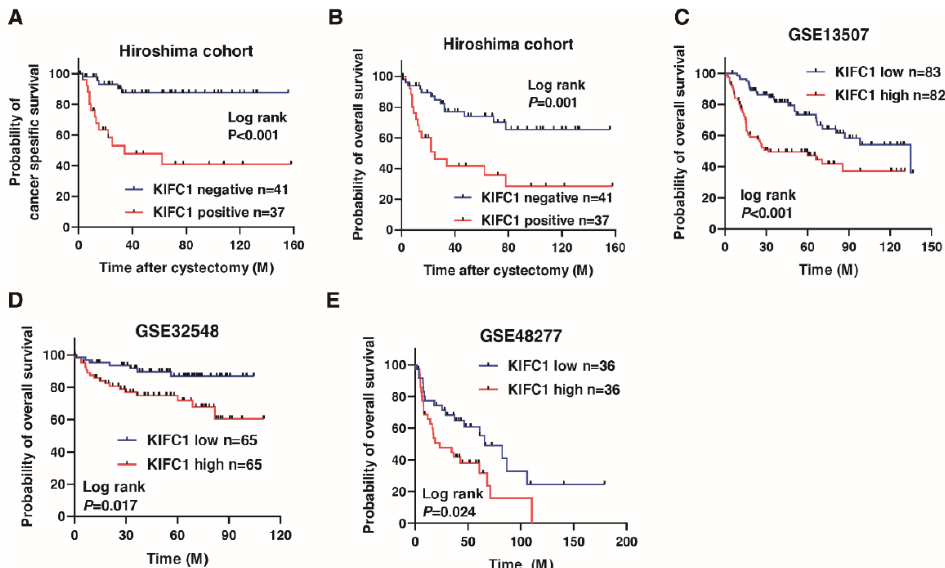
Figure 2. Prognostic value of KIFC1 after cystectomy in bladder cancer (BC). ( A – E ) Kaplan-Meier plots of survival of BC patients after cystectomy according to KIFC1 expression in the Hiroshima cohort and public databases (GSE13507, GSE32548, and GSE48277). Table 2. Univariate and multivariate Cox regression analysis of overall survival in 78 bladder cancer. Univariate Analysis Multivariate Analysis